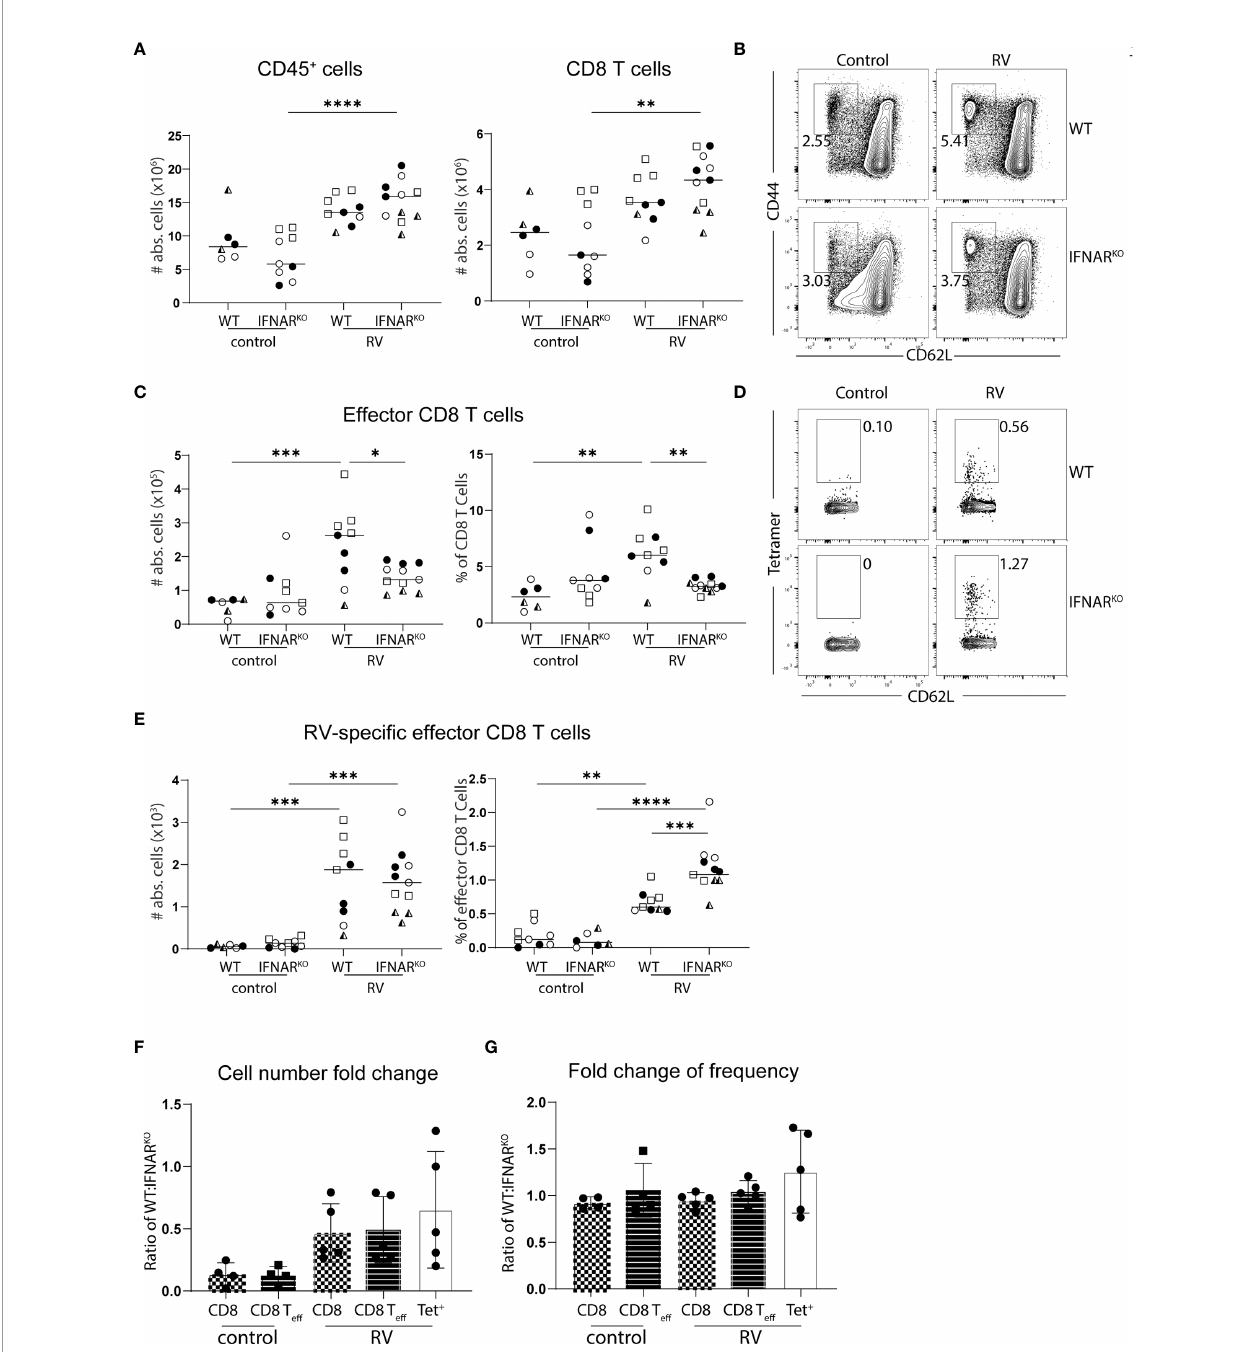
FIGURE 4 | Global de fi ciency of IFNAR leads to a loss of effector CD8 T cells without altering the RV-speci fi c CD8 T response. WT and IFNAR KO mice were infected with RV. (A – G) MLN cells isolated from uninfected control and RV infected WT and IFNAR KO mice seven days post oral infection. (A) Total number of CD45 + cells and CD8 T cells (CD45 + CD3 + CD4 - CD8 a + ). (B) Representative FACS plot of effector CD8 T cells (CD62L - CD44 + ) pre-gated on CD45 + CD3 + CD4 - CD8 a + cells. (C) Absolute cell numbers and frequency of effector CD8 T cells (CD62L - CD44 + ). (D) Representative FACS plot of RV-speci fi c effector CD8 T cells (CD44 + CD62L - Tet + ). (E) Absolute cell numbers and frequency of RV-speci fi c effector CD8 T cells. Each data point represents one mouse from a total of four different experiments, indicated by the different symbols. Ordinary one-way ANOVA with Tukey´s multiple comparison test was performed for statistical analysis. *p < 0.05, **p < 0.01, ***p < 0.001, ****p < 0.0001. Fold change of (F) absolute cell number and (G) frequency of indicated cells in mixed bone marrow chimeras of 50:50 WT : IFNAR KO into WT recipients. Each data point represents one mouse from 2 independent experiments with 2-3 mice per group. Ordinary one-way ANOVA with Tukey´s multiple comparison test was performed for statistical analysis. Data not signi fi